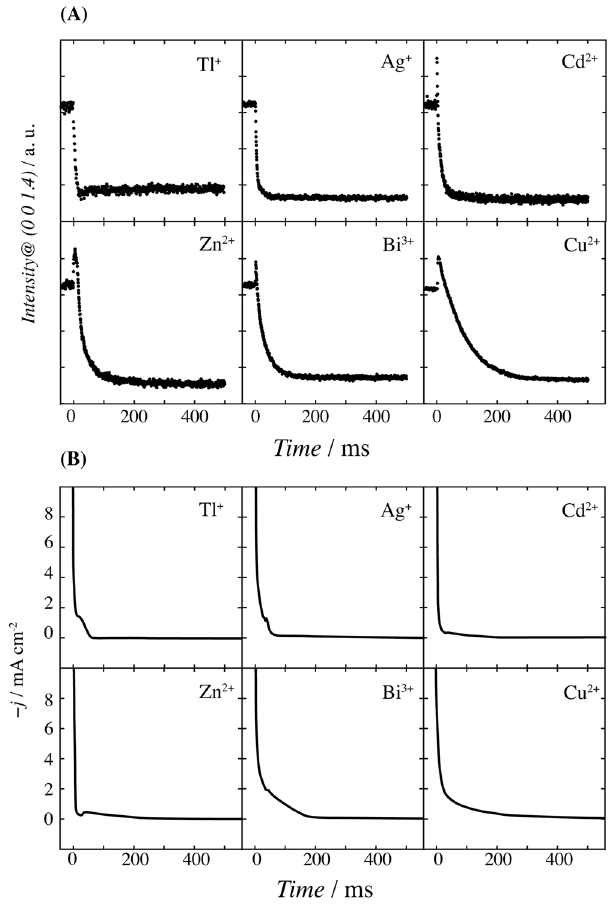
Figure 3. ( A ) TRSXRD at 0 0 1.4 with the time resolution of 500 μ s and ( B ) current transient during the deposition of various metal cations on Au(111): Tl upd in 0.5 M H 2 SO 4 + 0.5 mM Tl 2 SO 4 form 0.20 V to − 0.40 V, Ag upd in 0.5 M H + 0.5 mM Ag 2 SO 4 2 SO 4 from 1.25 V to 0.75 V, Cd upd in 0.5 M H 2 SO 4 CdSO 4 from 0.60 V to 0.10 V, Zn upd in 0.5 M Na 2 HPO 4 + 1.0 mM Zn(ClO 4 ) 2 from 0.30 V to − 0.30 V, Bi upd in 1.0 M